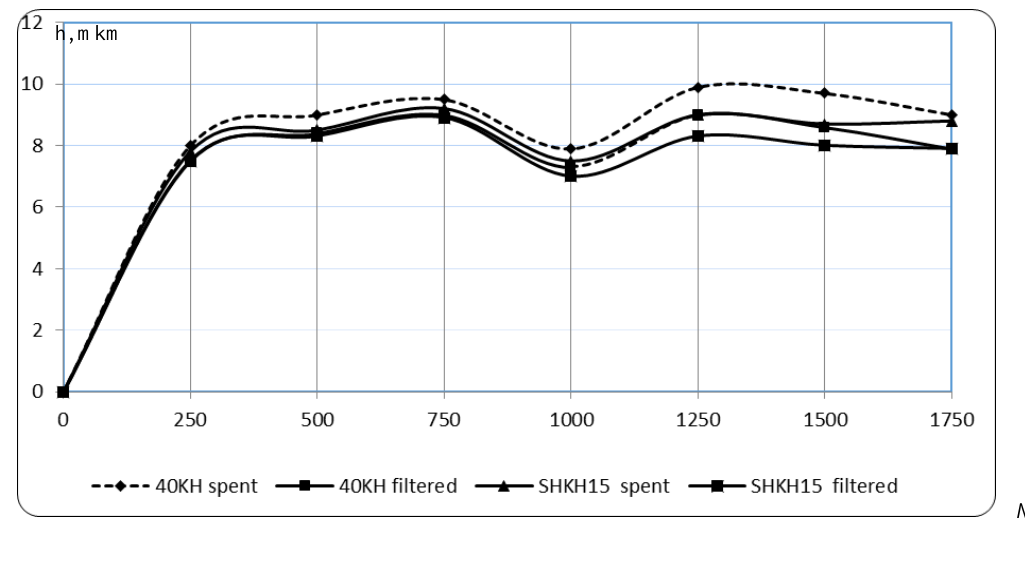
Fig. 3. Formation of the lubricating film thickness in contact with used samples of Mobil-1 0w-40 engine oil depending on the hardness of the surface